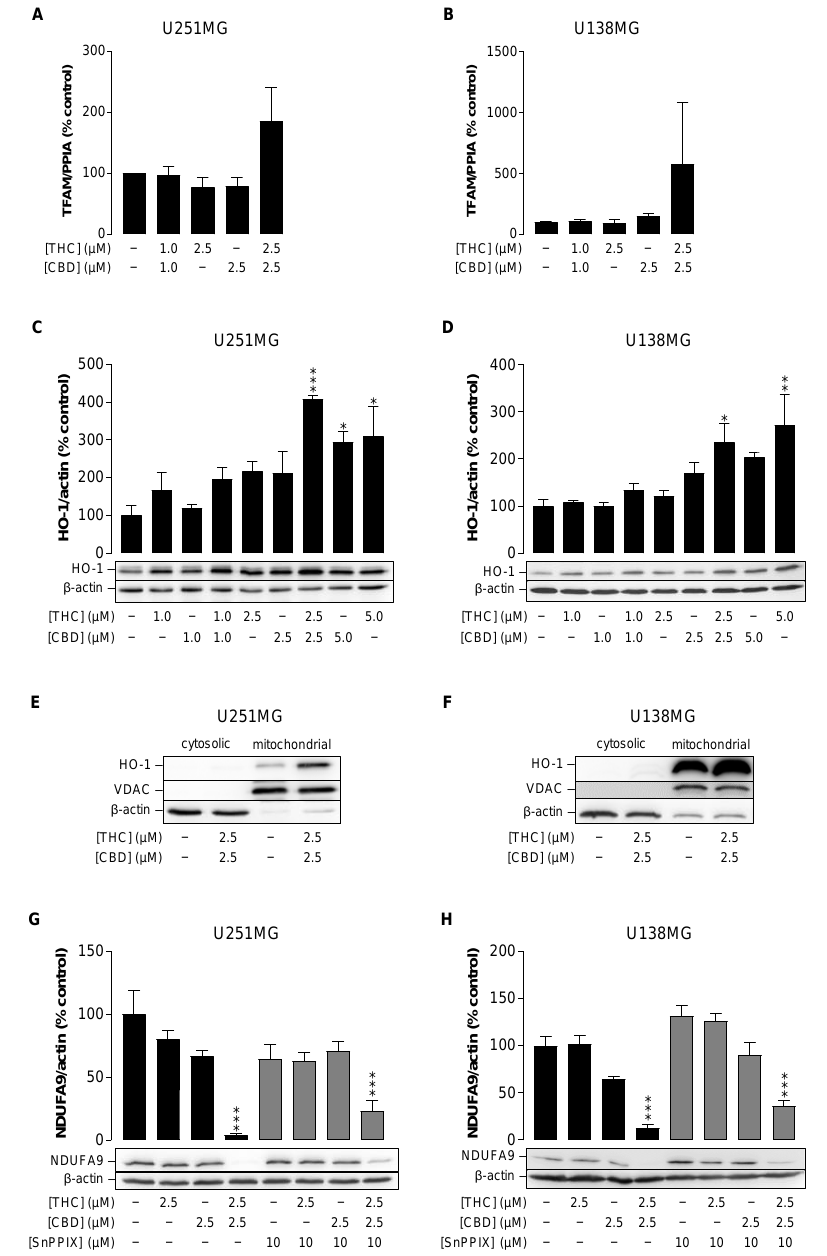
Figure 6. Influence of THC and CBD, administered alone or in combination, on mitochondrial tran- scription factor A (TFAM) expression ( A , B ) and heme oxygenase-1 (HO-1) protein levels ( C – F ) and function ( G , H ) in human glioblastoma cells. U251MG and U138MG cells were incubated with selected concentrations of THC and CBD, their combination (in a ratio of 1:1) or vehicle control for 24 h. In the experiments shown in Panels ( G , H ), the HO inhibitor SnPPIX (10 µM) was applied to the cells 1 h before the cannabinoids and was present throughout the incubation with the cannabinoids. Following incubation with cannabinoids, total RNA ( A , B ), cellular total protein ( C , D , G , H ) or mitochondrial fractions ( E , F ) were isolated and analysed for TFAM or HO-1. All percentage values shown refer to the vehicle control, which was set to 100%. The values given in the bar charts are based on RT-PCR ( A , B ) or densitometric analyses of blots ( C , D , G , H ), with the gene of interest normalised to PPIA ( A , B ) and the proteins normalised to β-actin ( C , D , G , H ). The blots shown are representative. The data in panels ( A – D , G , H ) are mean values ± SEM of n = 3–5 independent experiments per group. * p ≤ 0.05, ** p ≤ 0.01, *** p ≤ 0.001 vs. corresponding vehicle control, one-way ANOVA with Dunnett’s post hoc test ( A – D ) or Bonferroni’s post hoc test ( G , H ).